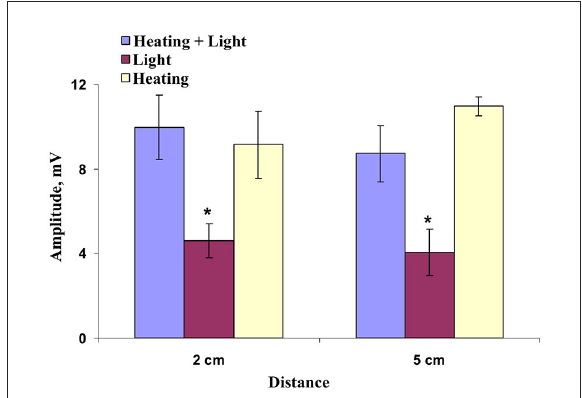
FIGURE7 Dependence of the amplitude of hyperpolarization electrical signals in wheat plants on distance from the zone of the local action of combination of illumination and heating (“Heating + Light”), only illumination (“Light”), and only heating (“Heating”) ( n = 6–10). Depolarization electrical signals were not analyzed. The 0cm distance was not analyzed because both depolarization and hyperpolarization electrical signals were generated on this distance. *, values were significantly differed from ones in the “Heating + Light” variant ( p < 0.05). Vertical bars represent standard